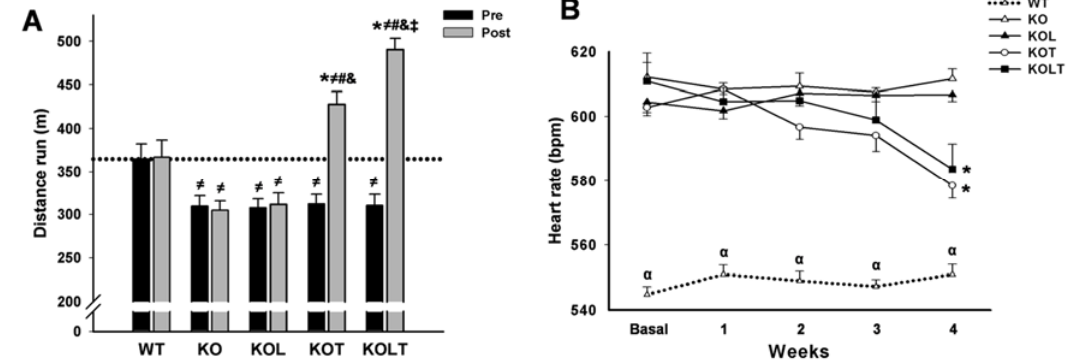
Figure 1. Exercise tolerance ( A ) and heart rate ( B ) in wild type (WT); α 2A / α 2C ARKO mice placebo (KO) or leucine (KOL), and exercise trained (KOT) or exercise trained leucine-suplemented (KOLT). Data are presented as mean ± SE. n = 9–12 per group. * p < 0.05 vs. Pre; ≠ p < 0.05 vs. WT; # p < 0.05 vs. KO; & p < 0.05 vs. KOL; ‡ p < 0.05 vs. KOT; α p < 0.05 vs. other